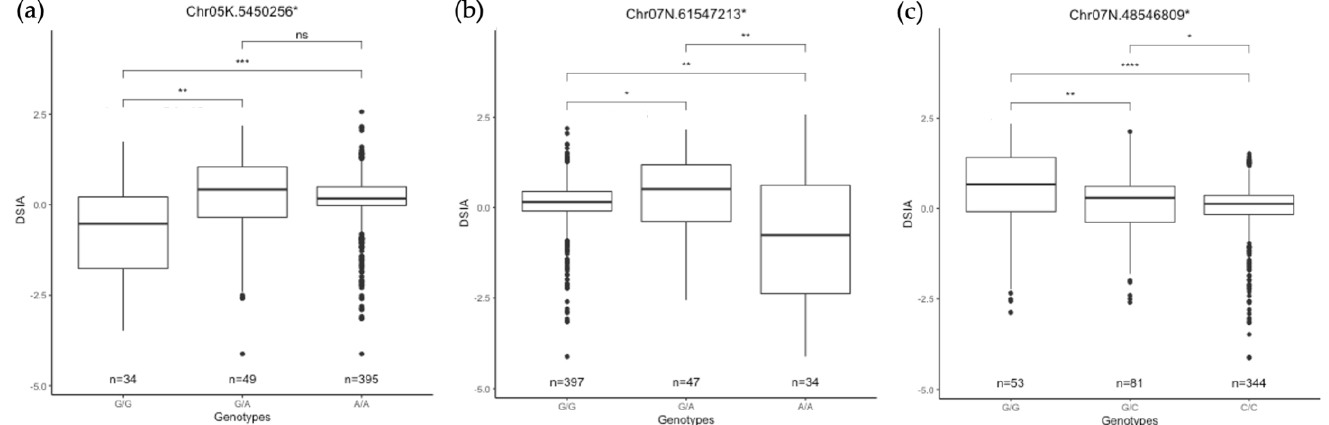
Figure 5. Examples of changes in DSIA associated with alleles at selected candidate SNP among 478 genotypes. The “*” behind the SNP names mean P. virgatum genes that overlap with the BLAST hits from BLS resistance genes from Oryza sativa . ( a ) Chr05K.5450256 showed a dominant effect. ( b ) Chr07N.61547213 showed an overdominant effect. ( c ) Chr07N.48546809 showed an additive effect. The effects of three different allele combinations were tested at alpha = 0.05. “ns” means non -signif- icant, “*” means significant at alpha 0.05, “**” means significant at alpha 0.01, “***” means significant at alpha 0.001, and “*** * ” means significant at alpha 0.00 01.